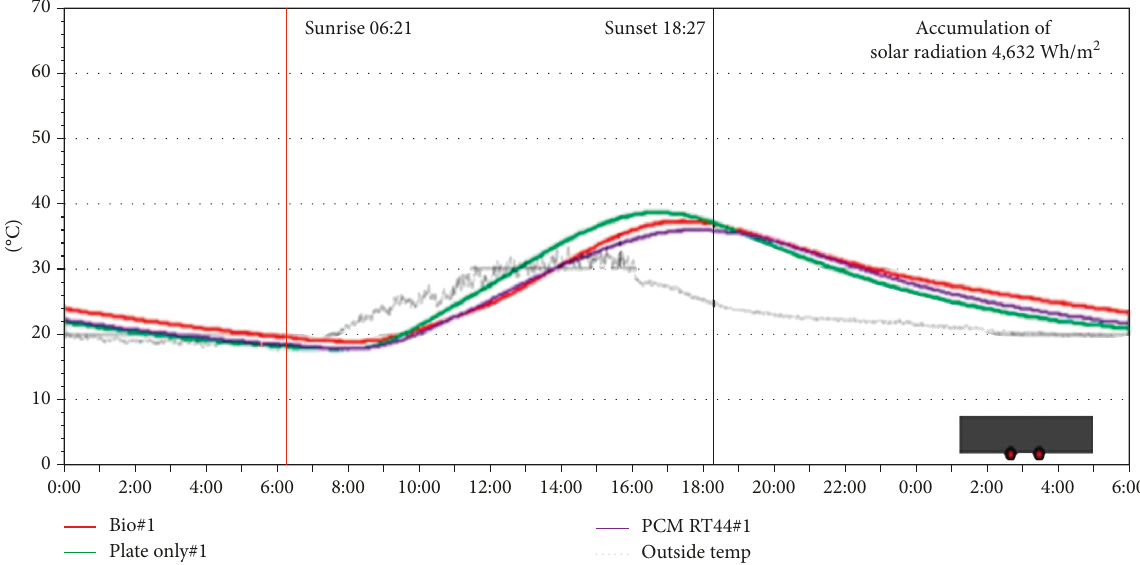
Figure 7: Ceiling temperature graph of Test